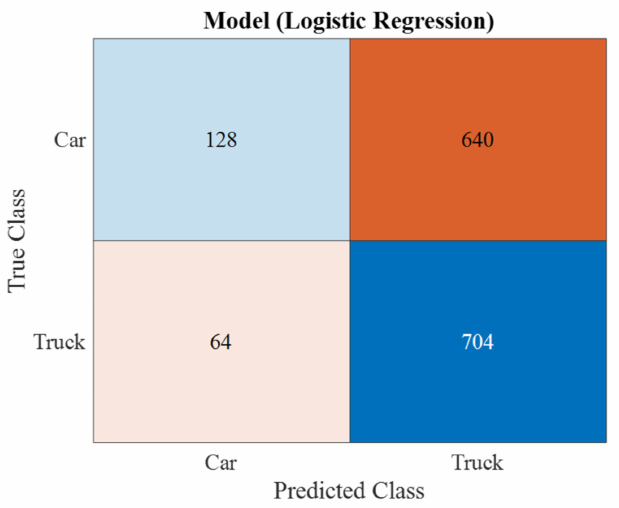
Figure 10. Confusion matrix for circular polarization (algorithm—logistic regression (54%); the hyper parameter option is